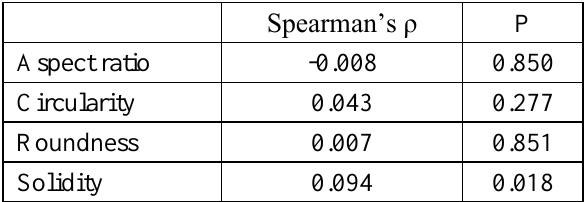
Table 3. Correlation coefficients for age or depth and